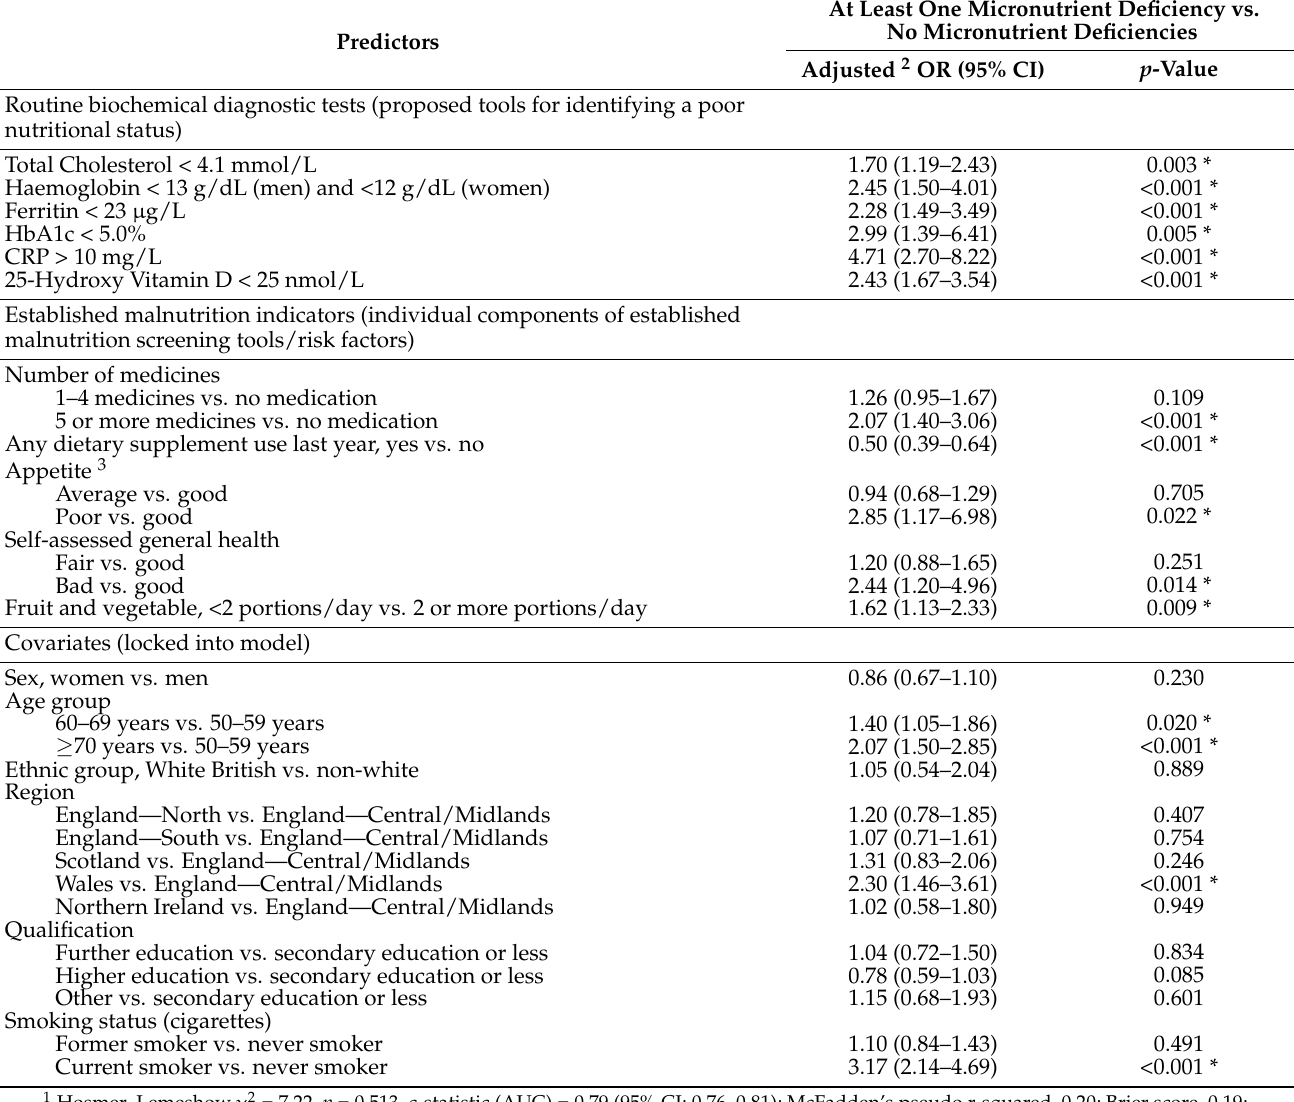
Table 7. Final model predicting a poor nutritional status (presence of at least one micronutrient deficiency) ( n = 1518) 1 , resulting from stepwise backward selection in a logistic regression analysis including all routine biochemical diagnostic tests, established malnutrition indicators and covariates. Covariates were locked in the model (Stage 4). At Least One Micronutrient Deficiency vs. No Micronutrient Deficiencies Predictors Adjusted 2 OR (95% CI) p